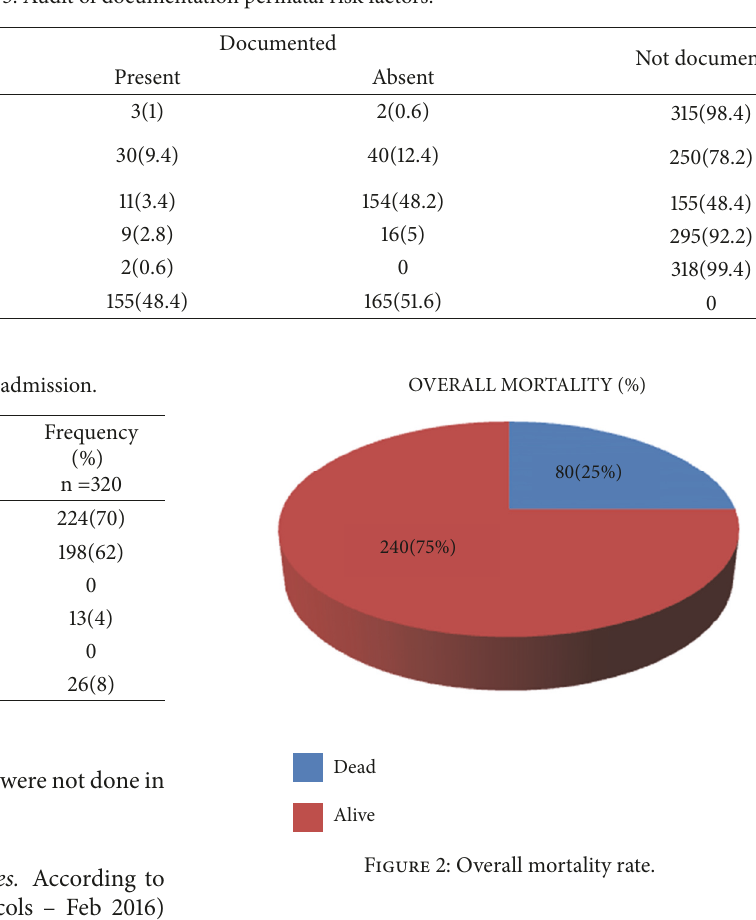
Table 3: Audit of documentation perinatal risk factors.